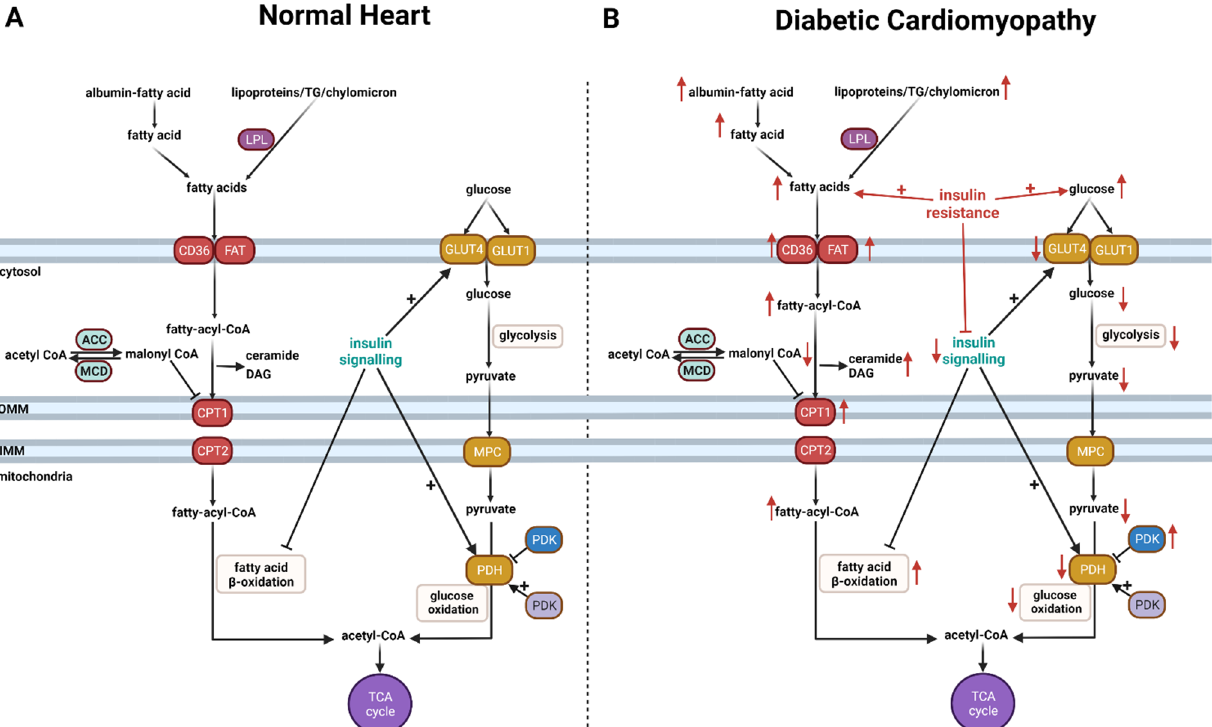
Figure 1. Cardiac energy metabolism in the normal heart ( A ) and in diabetic cardiomyopathy ( B ). There are accelerated rates of cardiac fatty acid uptake and β -oxidation in diabetes that are associated with marked reduction in the rates of cardiac glucose uptake and oxidation in diabetic cardiomyopathy. The occurrence of cardiac insulin resistance and impaired insulin signaling contribute to these changes in glucose and fatty acid oxidation in diabetic cardiomyopathy. An arrow facing up indicates an increase and down indicates a decrease. LPL, lipoprotein lipase; FAT, fatty acid translocase; ACC, acetyl CoA carboxylase; MCD, malonyl CoA decarboxylase; MPC, mitochondrial pyruvate carrier; PDP, pyruvate dehydrogenase phosphatase; PDK, pyruvate dehydrogenase kinase; OMM, outer mitochondrial membrane; IMM, inner mitochondrial membrane; CD36, fatty acid transporter; CPT1, carnitine palmitoyltransferase 1; CPT2, carnitine palmitoyltransferase 2; GLUT1, glucose transporter 1; GLUT4, glucose transporter 4; MPC, mitochondrial pyruvate carrier; PDH, pyruvate dehydrogenase; TCA, tricarboxylic acid cycle; TG, triaceylglycerol.